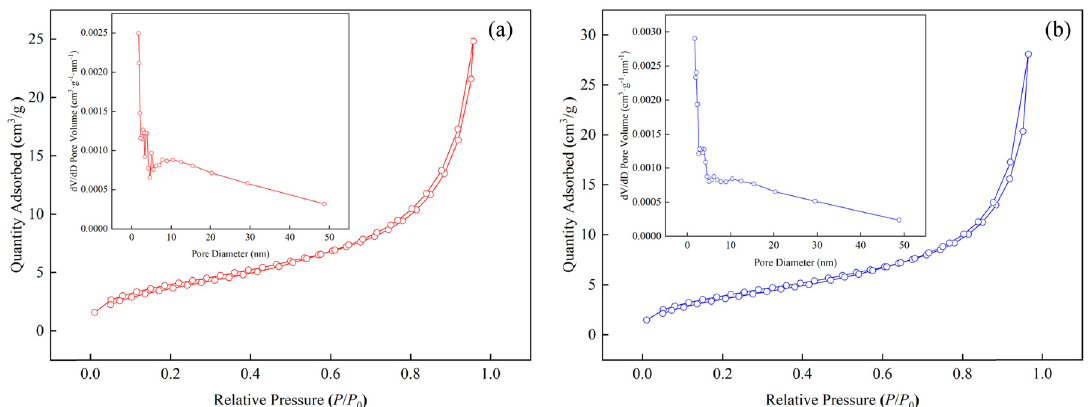
Figure 3: BET isotherms of IICM ( a ) and NICM ( b ) .